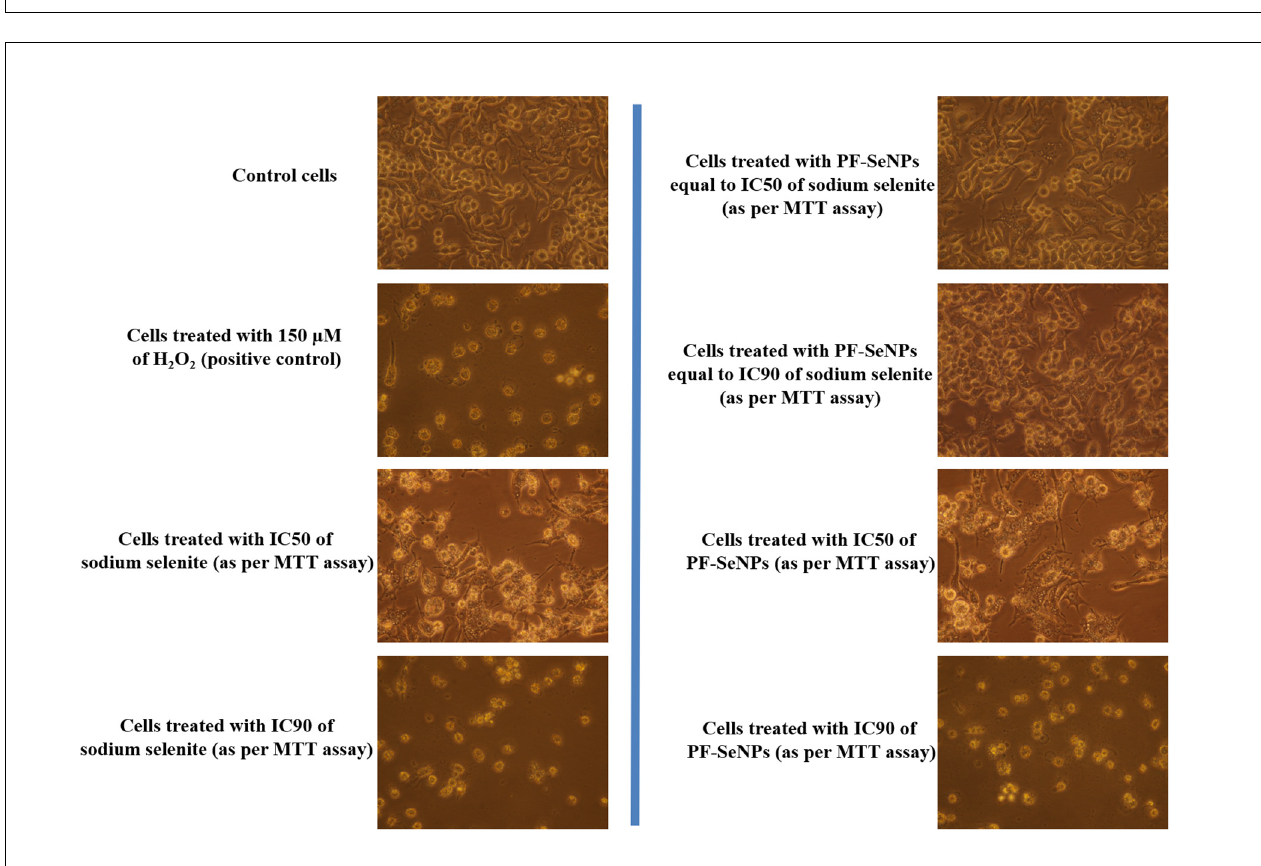
FIGURE 9 | Bright-field microscopic images of N2a cells treated with 150 µ M of H 2 O 2 and different concentrations of sodium selenite and phytofabricated selenium nanoparticles (PF-SeNPs) for 24 h. All images were captured at magnification of 400 × .